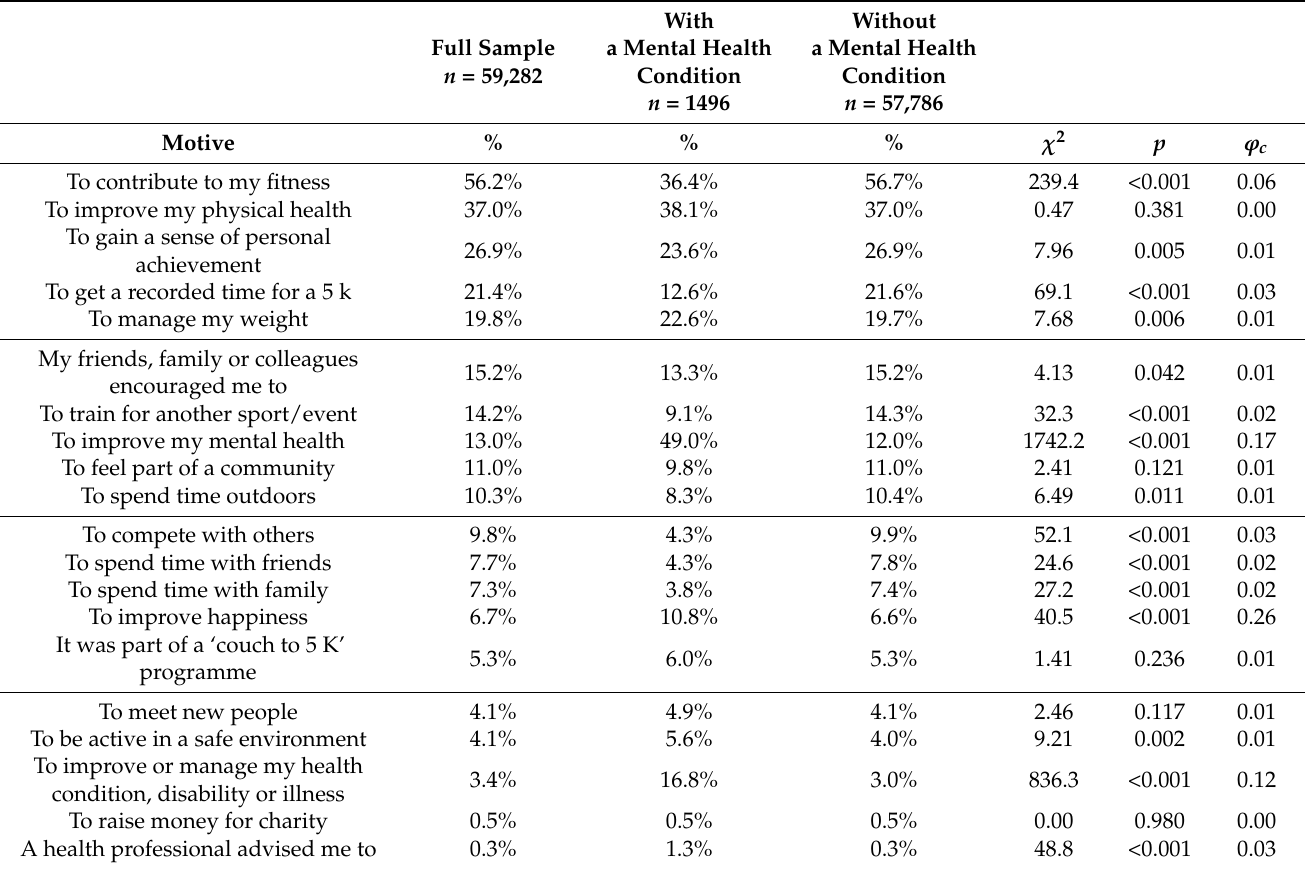
Table 4. Response to the question “What motivated you to first participate at parkrun as a runner or walker?” Participants ( n = 59,243) were able to select up to three